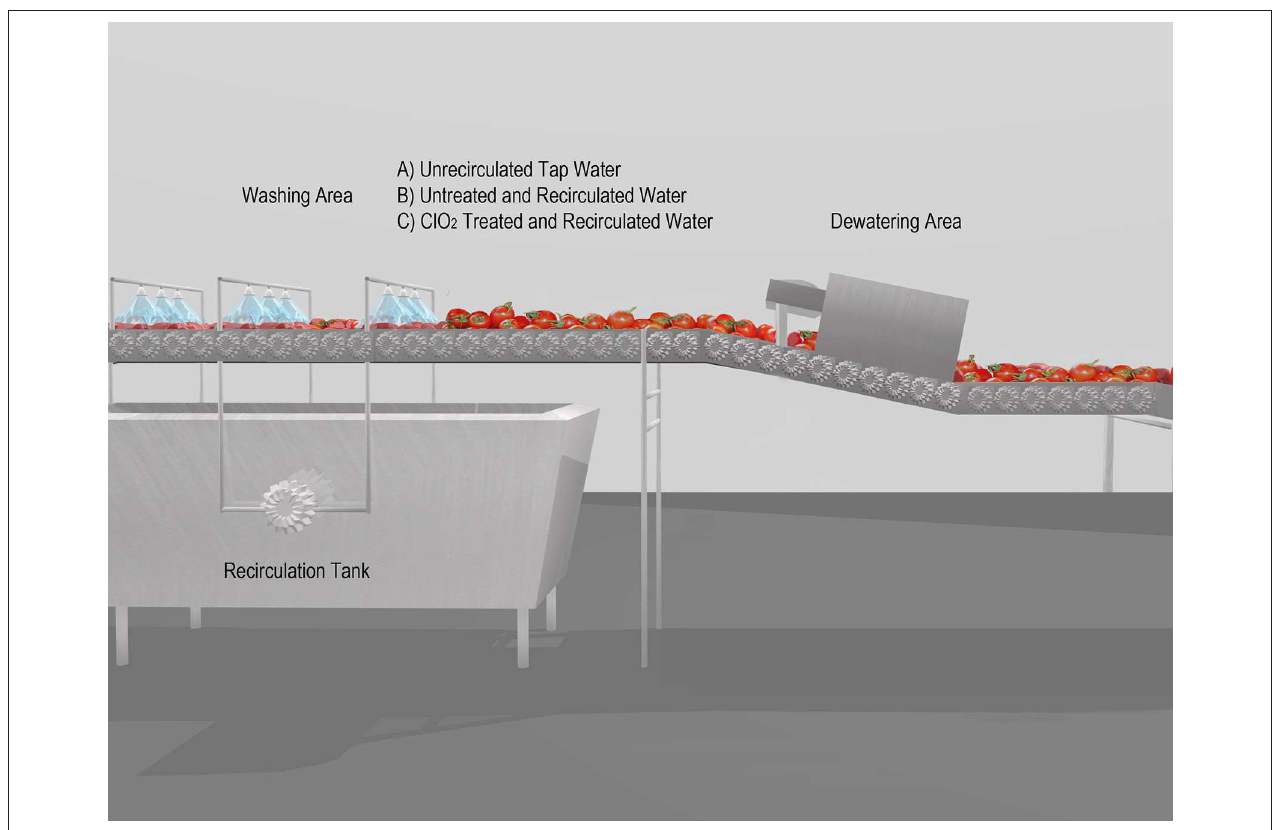
FIGURE 1 | Tomato washer used for the different